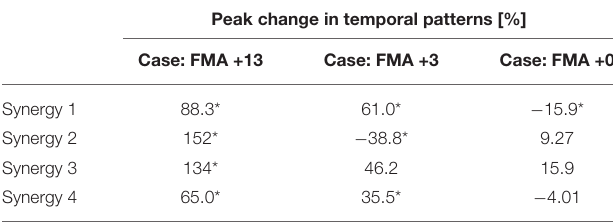
TABLE 3 | Temporal synergy patterns progression in subacute